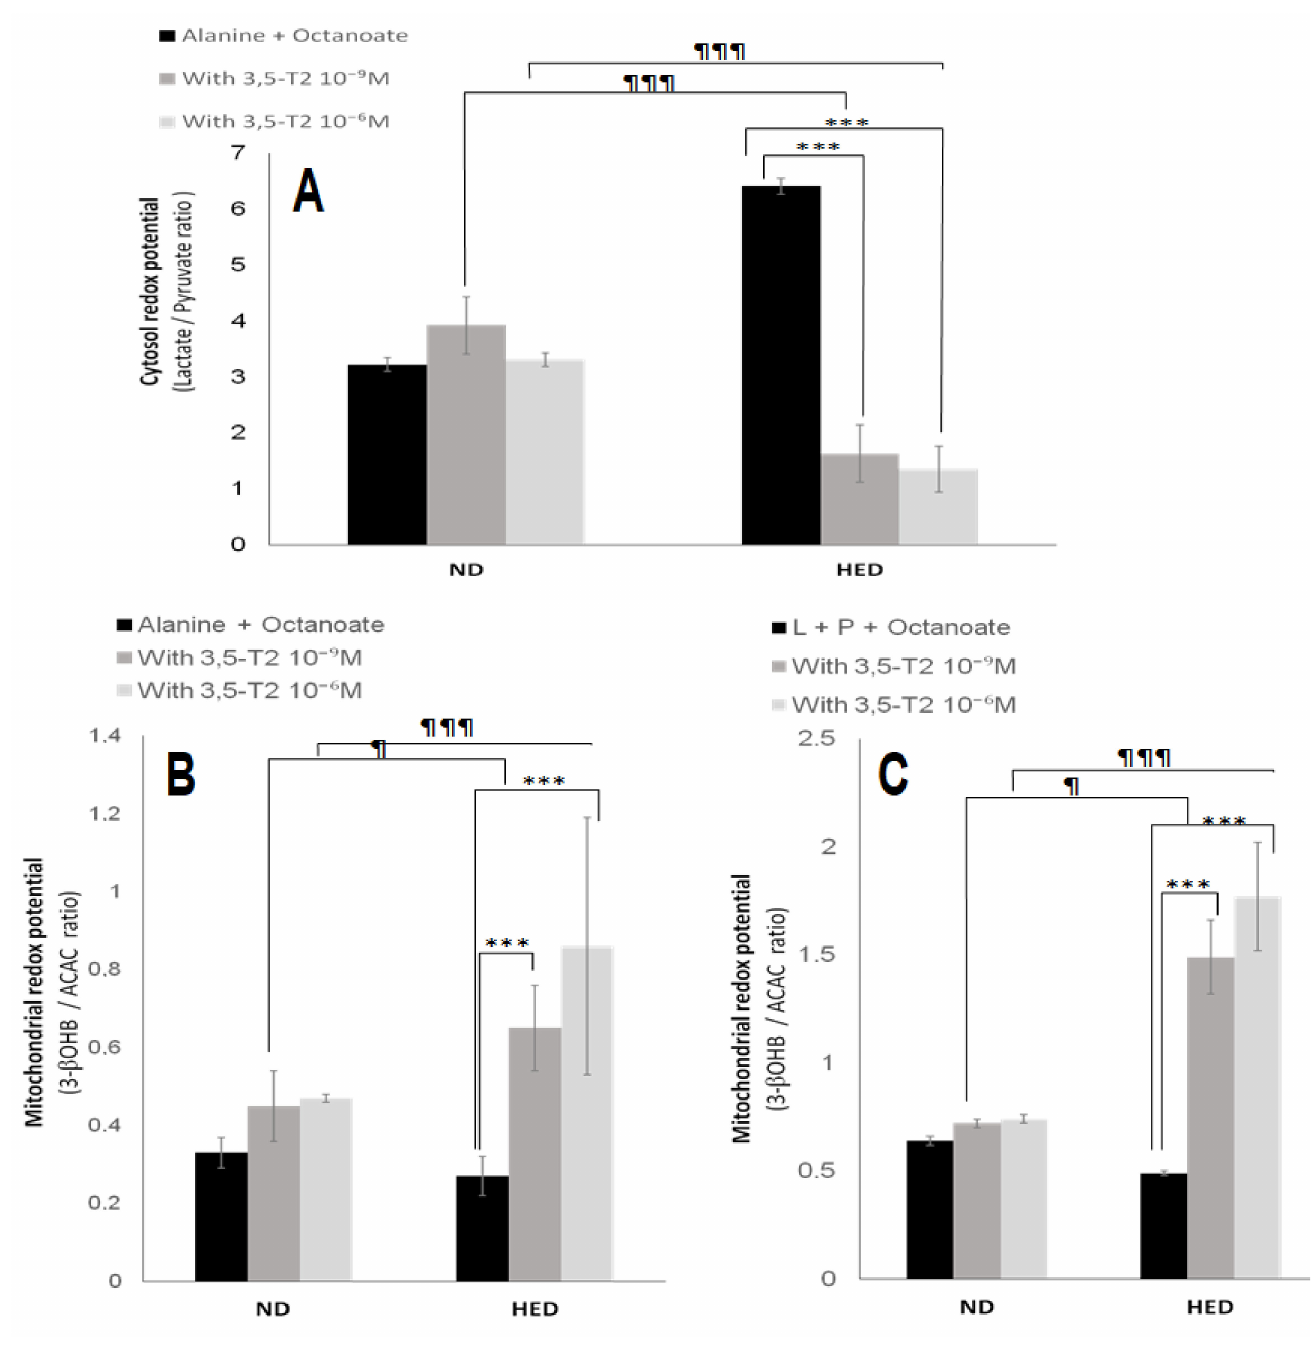
Figure 3. Effects of 3,5-T2 on both cytosolic and mitochondrial redox potential (NADH/NAD + ) in iso- lated hepatocytes from experimental P. obesus fed ND or HED. ND: Natural Diet, HED: High Energy Diet. Freshly isolated hepatocytes from 16 h-fasted P. obesus were incubated in Krebs/bicarbonate, buffer containing alanine or lactate (L) + pyruvate (P) together with octanoate in the absence or presence of 3,5-T2 (10 − 9 or 10 − 6 M). Cytosol redox potential is represented by the L/P ratio ( A ). Mito- chondrial redox potential is represented by the β - hydroxybutyrate/acetoacetate ratio ( β -HB/AcAc) ( B , C ). Data are expressed as mean ± SEM. *** p < 0.001 compared 3,5-T2-treated group versus HED placebo group. ¶ p < 0.05; ¶¶¶ p < 0.001 compared 3,5-T2-treated group versus ND placebo group. ns: no